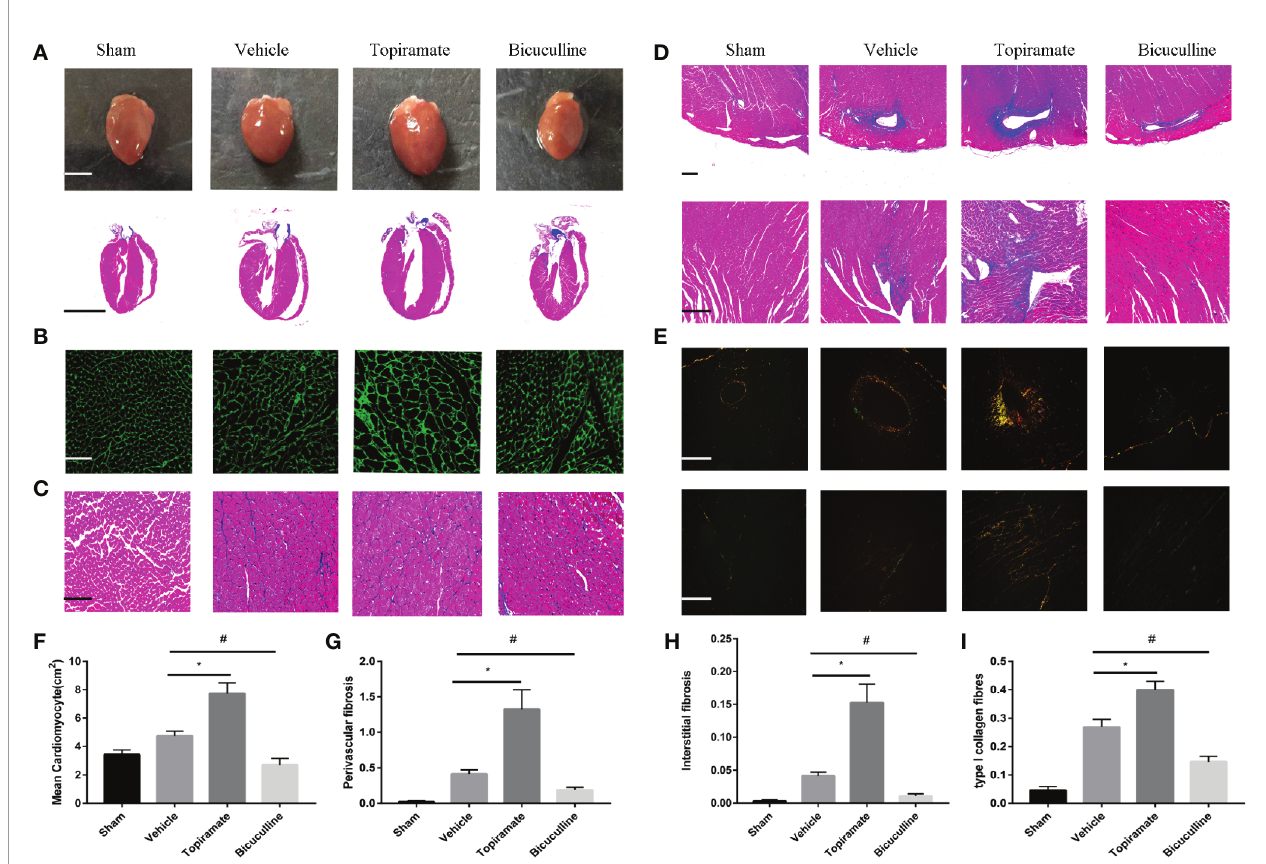
FIGURE 2 | Activation or blockade of the GABA A receptor promotes or alleviates myocardial remodeling in pressure-overload hypertrophy mice. (A) Representative visible images of hearts (top) and Masson trichrome staining of heart vertical section (bottom) at day 28 post-TAC. Scale bar = 2.5 mm. (B, C) Cardiomyocytes by wheat germ agglutinin (WGA) staining (B) , and Masson trichrome staining (C) at day 28 post-TAC. scale bar = 50 m m. (D, E) Cardiac fi brosis by Masson trichrome staining (D) , and Sirius Red staining (E) at day 28 post-TAC. (top, perivascular fi brosis; bottom, interstitial fi brosis). (F – I) Quanti fi ed analysis of cardiomyocytes size (F) , the perivascular collagen area relative to the vessel area (G) , the percentage of interstitial fi brosis area in each picture (H) , and the ratio of type I collagen fi brosis to total collagen-stained area (I) . Sections were analyzed with Image-Pro Plus 6.3 software. Data show the mean ± SEM, by one-way ANOVA with Bonferroni ’ s multiple comparison test. For topiramate treatment, *P < 0.05 vs. vehicle. For bicuculline treatment, # P < 0.05 vs. vehicle. (each group, n = 6 –